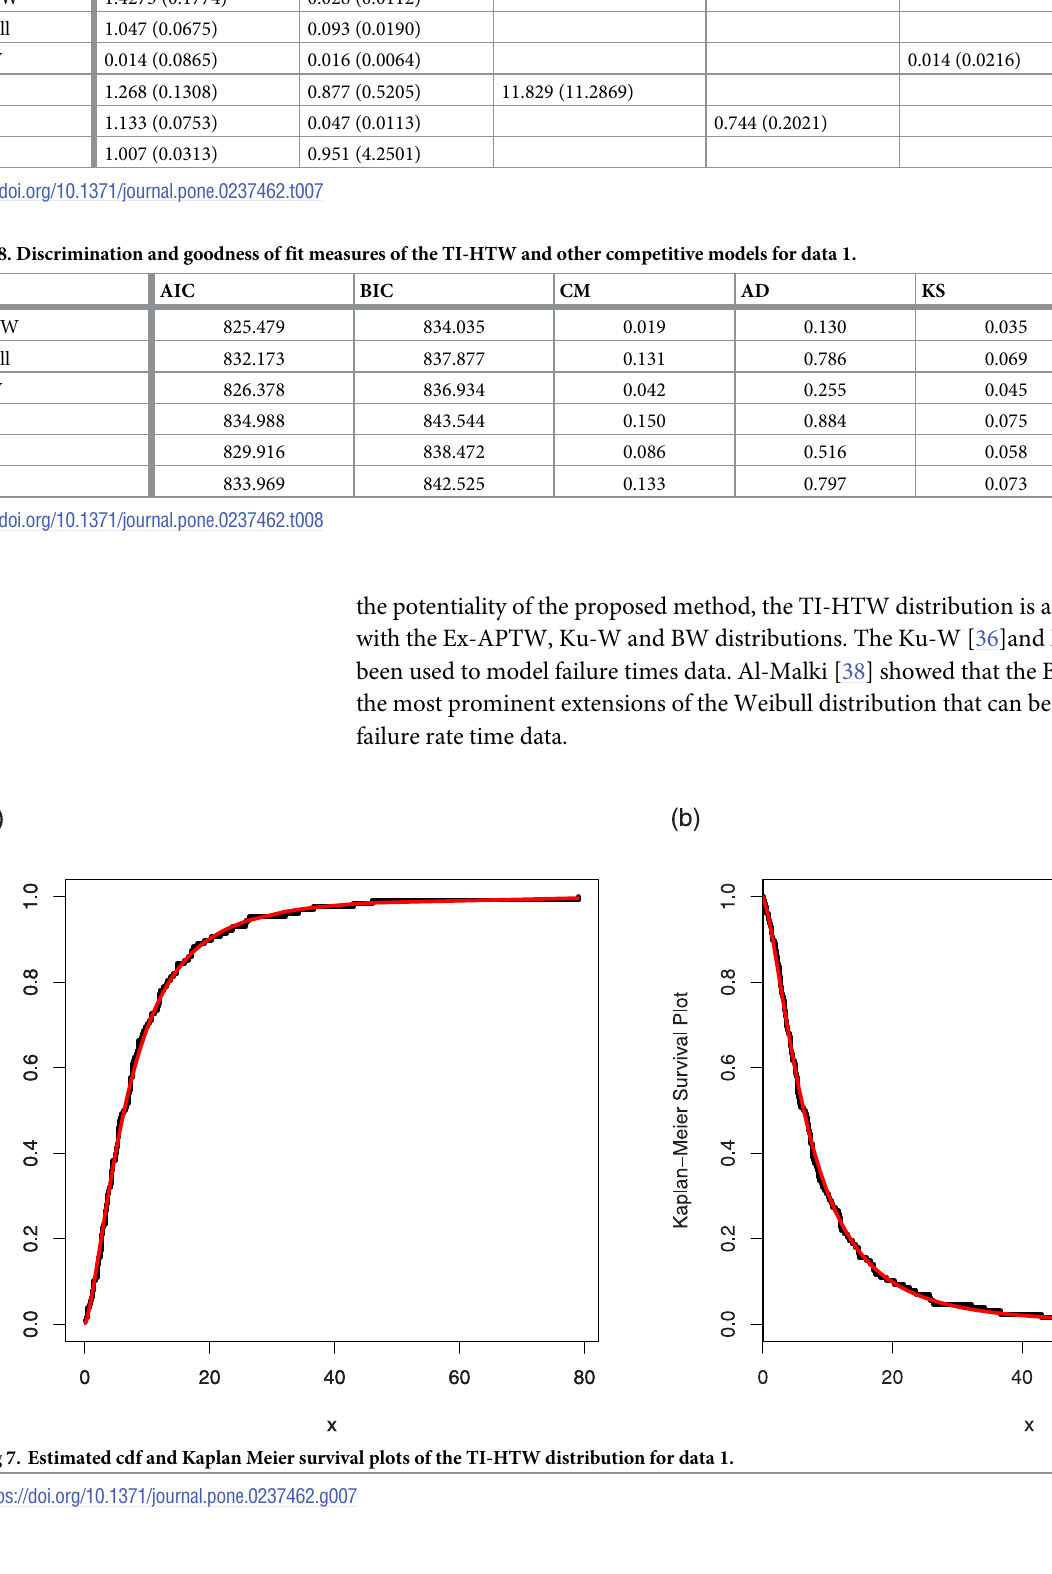
Table 7. Estimated values with standard error (in parenthesis) of the competitive models for data 1. Dist .